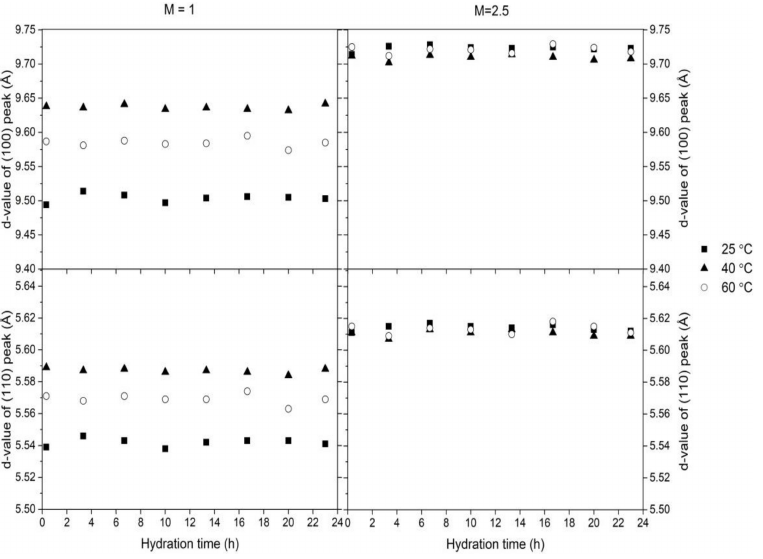
Figure 10. D-values of (100) and (110) peaks of ettringite during first 24 h of